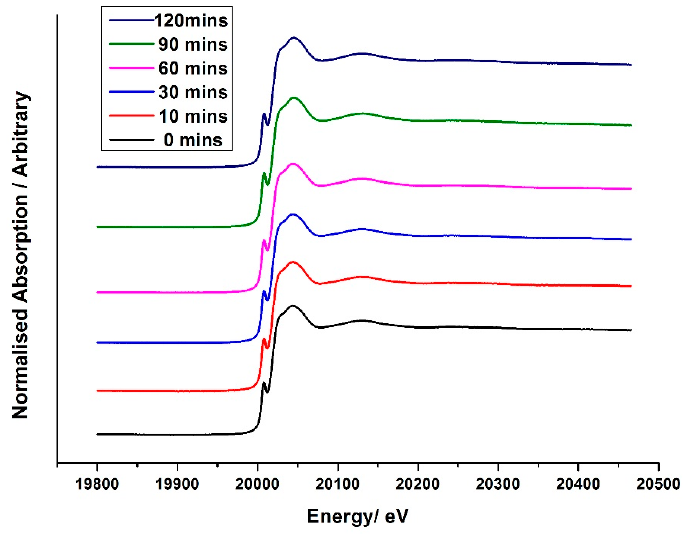
Figure 16. XANES data over a 120 min period for 6ML MoO x /Fe 2 O 3 when reacted isothermally at 250 °C under a continuous flow of MeOH/O 2 .